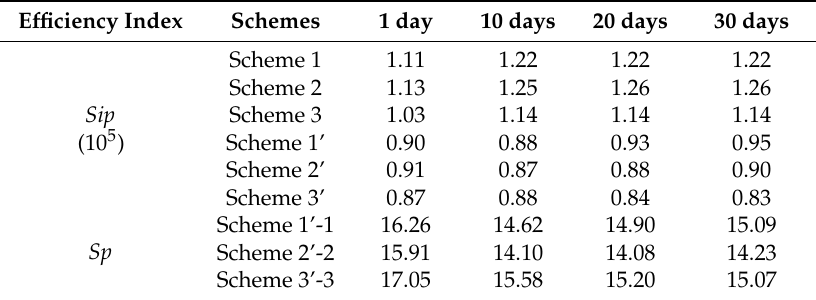
Table 4. Results of sip and Sp in modeling schemes with the three simulation times.